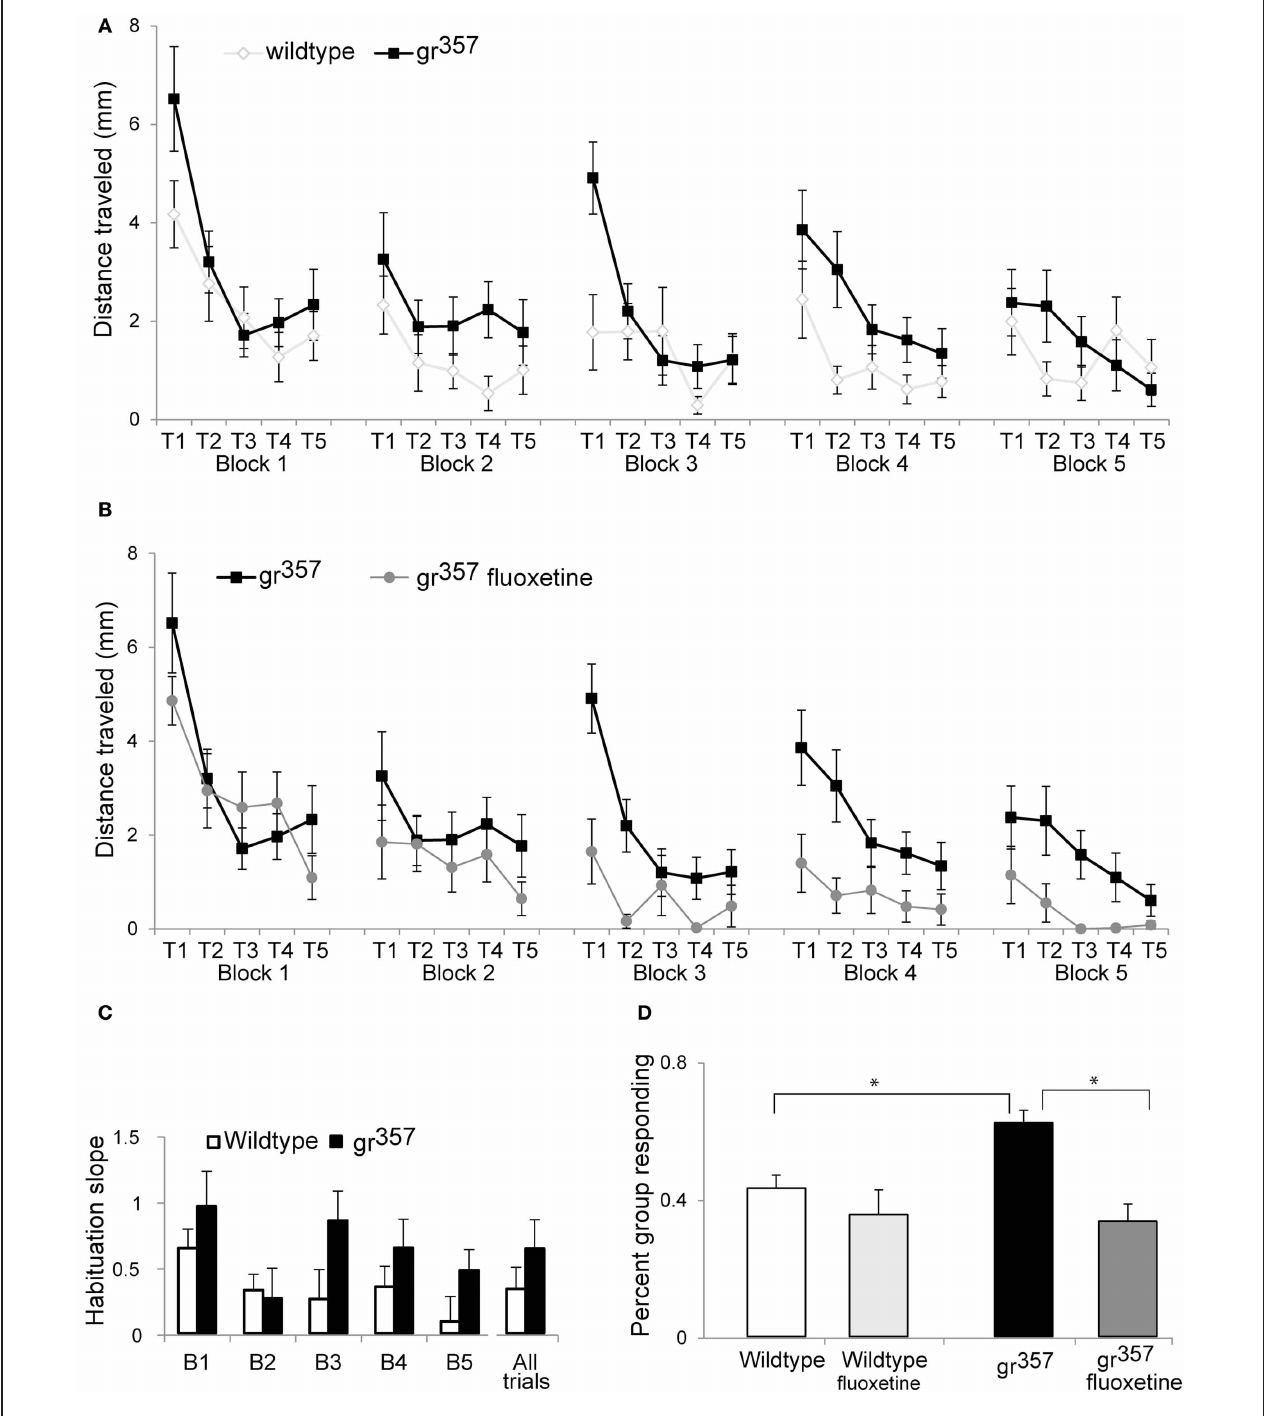
(C) Habituation within block shown as the slope of the regression line through the 5 trails on each block, and as an average of all 25 startle trials. Mutants had steeper habituation slopes (more habituation) in 4 out of 5 blocks, and across all 25 trials, reflecting the larger startle responses of mutants on the earliest trials of each block. This graph illustrates a trend in the data, but effect of genotype on habituation was not statistically significant. (D) Percent of group responding acrossall25trials.Untreated mutants responded significantly more frequently than wildtype groups or fluoxetine treated mutants ( ∗ P < 0 .